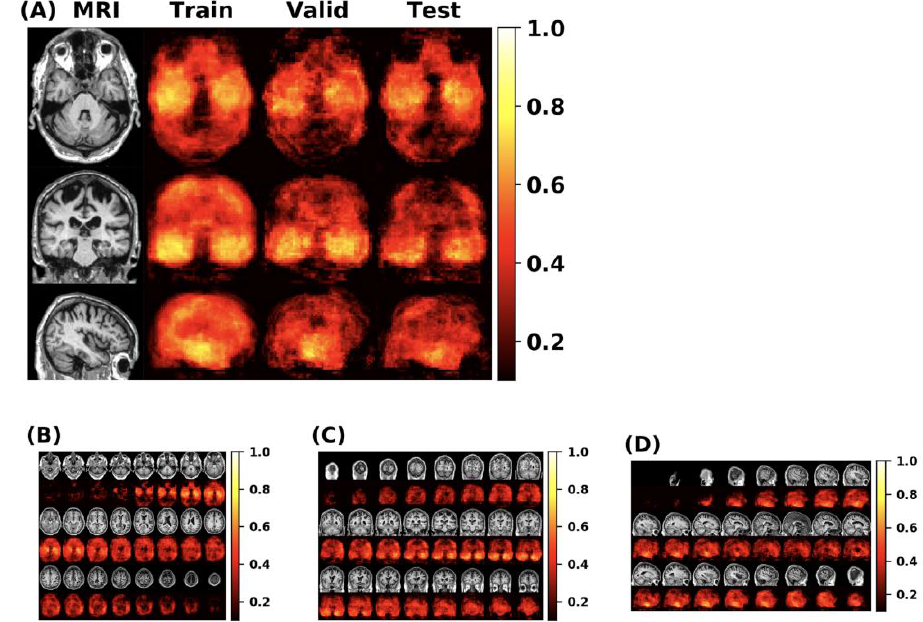
Figure 10. ( A ) The MCC value can show the overall classification performance of the FCN model. From the MCC heatmap, it can be observed that some locations have higher MCC values (that is, these locations have higher classification accuracy). The MLP model uses these specific locations as a region of interest (ROI). ( B – D ) represents the MCC value of the FCN model in the individual axial, coronal and sagittal